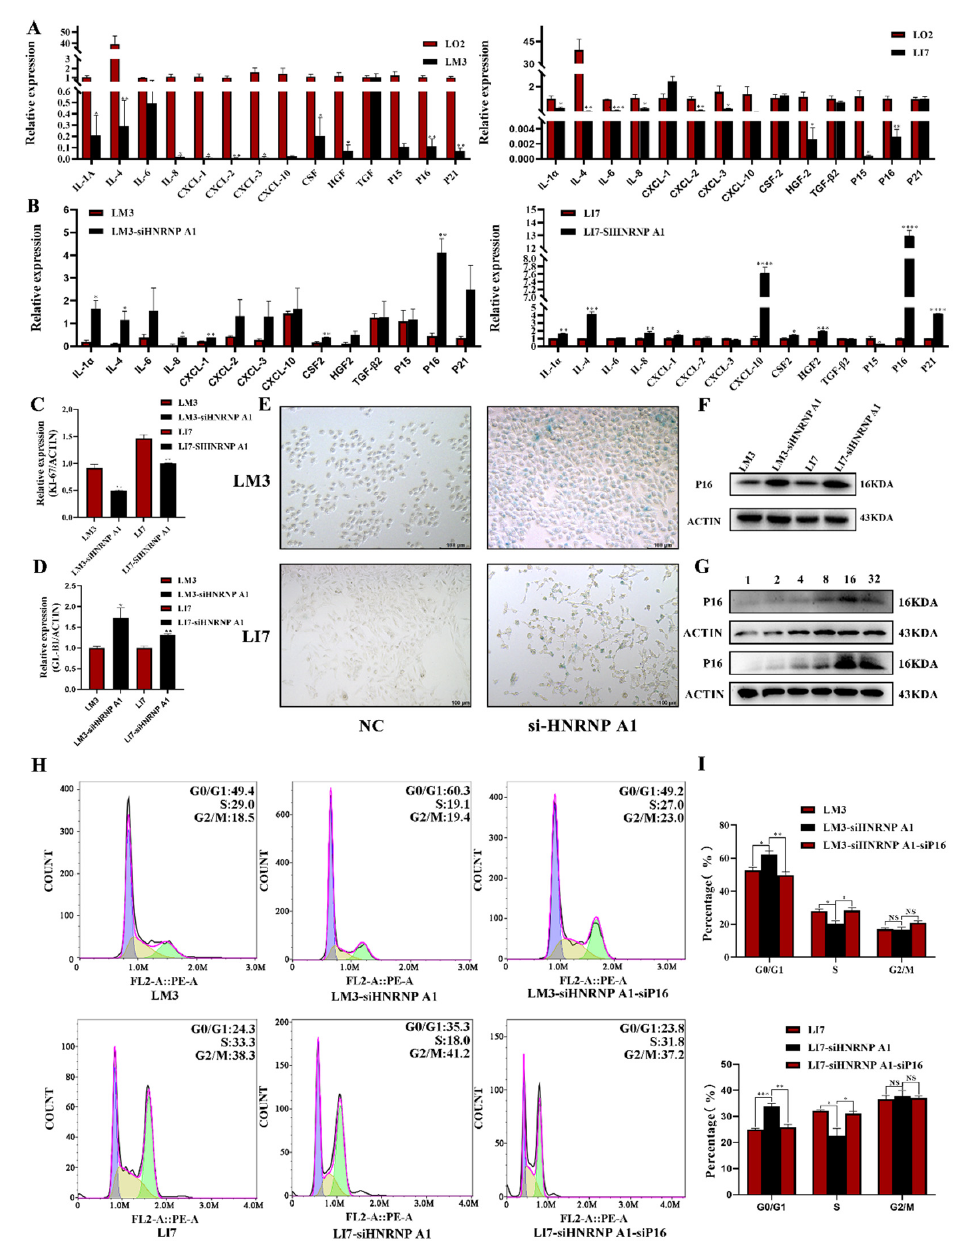
percentage of SA- β -Gal-positive cells was increased by HNRNP A1 knockdown in HCC cell lines. These results reveal that HNRNP A1 inhibits the senescence of hepatoma cells.